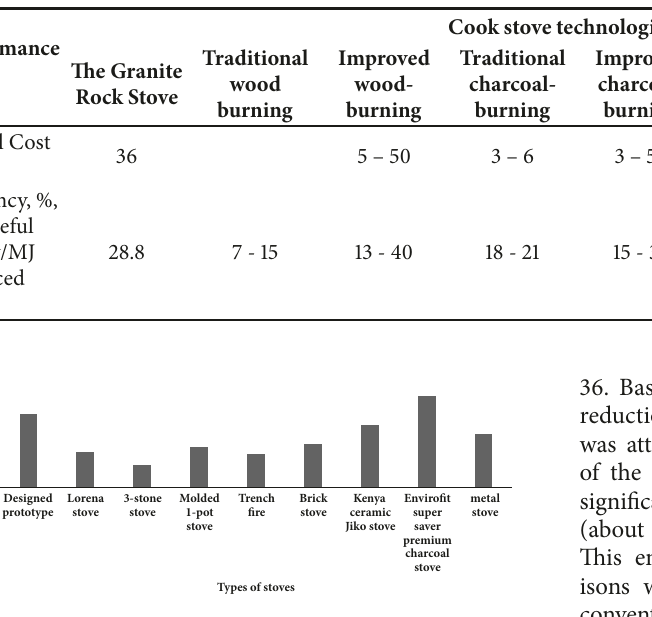
Figure 5: Comparisons between thermal efficiencies % of different